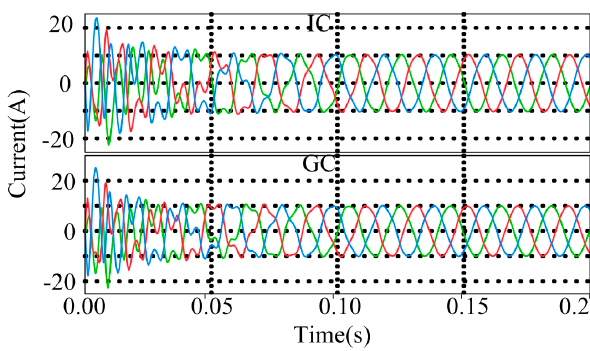
Figure 16. Grid-connected currents under different sampling currents when L g = 5 mH.